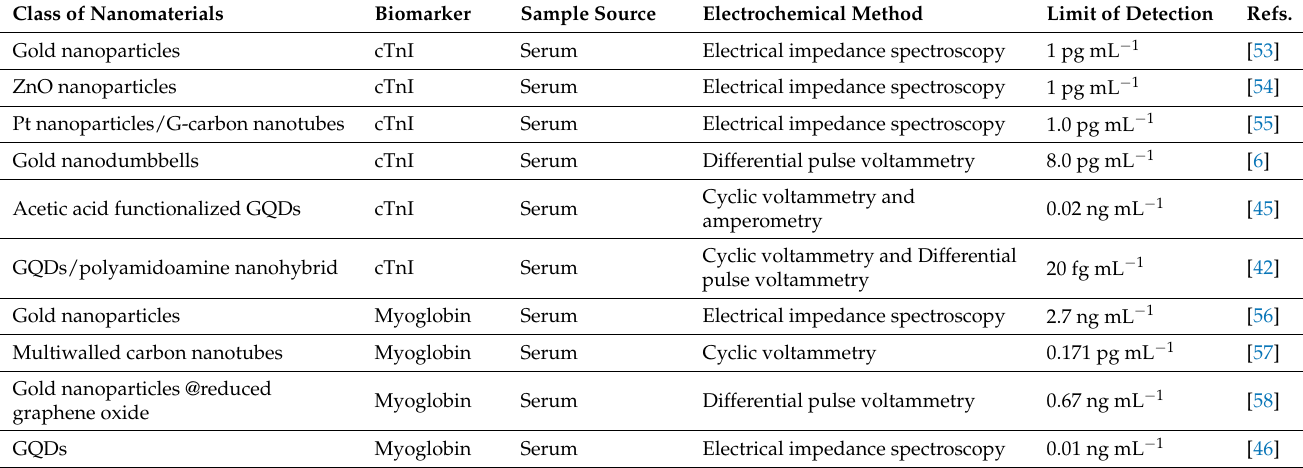
Table 1. Comparison of GQDs and other nanomaterials for the electrochemical detection of cTnI and myoglobin in terms of the detection method, detection range and detection